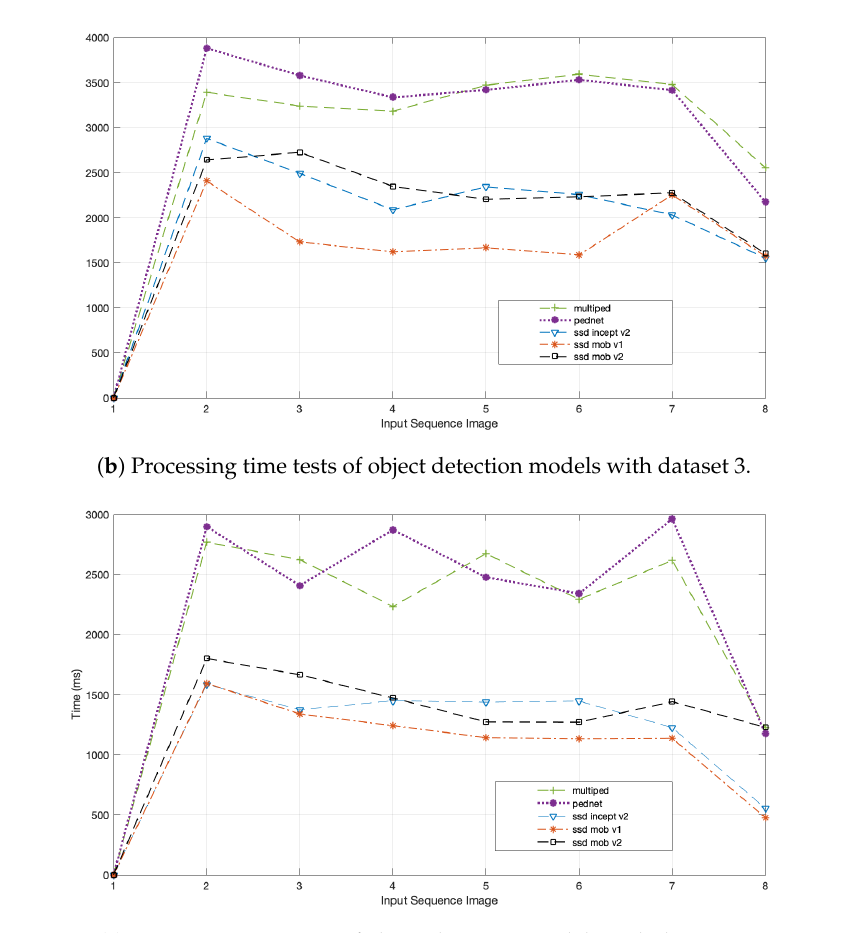
Figure 9. Evaluation of the processing time in the detection of vehicles and pedestrian in rural roads using different image